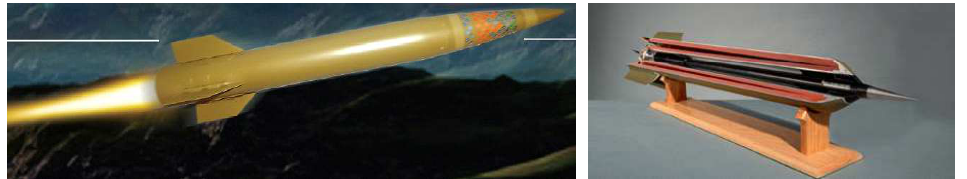
Figure 2. Examples of kinetic energy missiles.